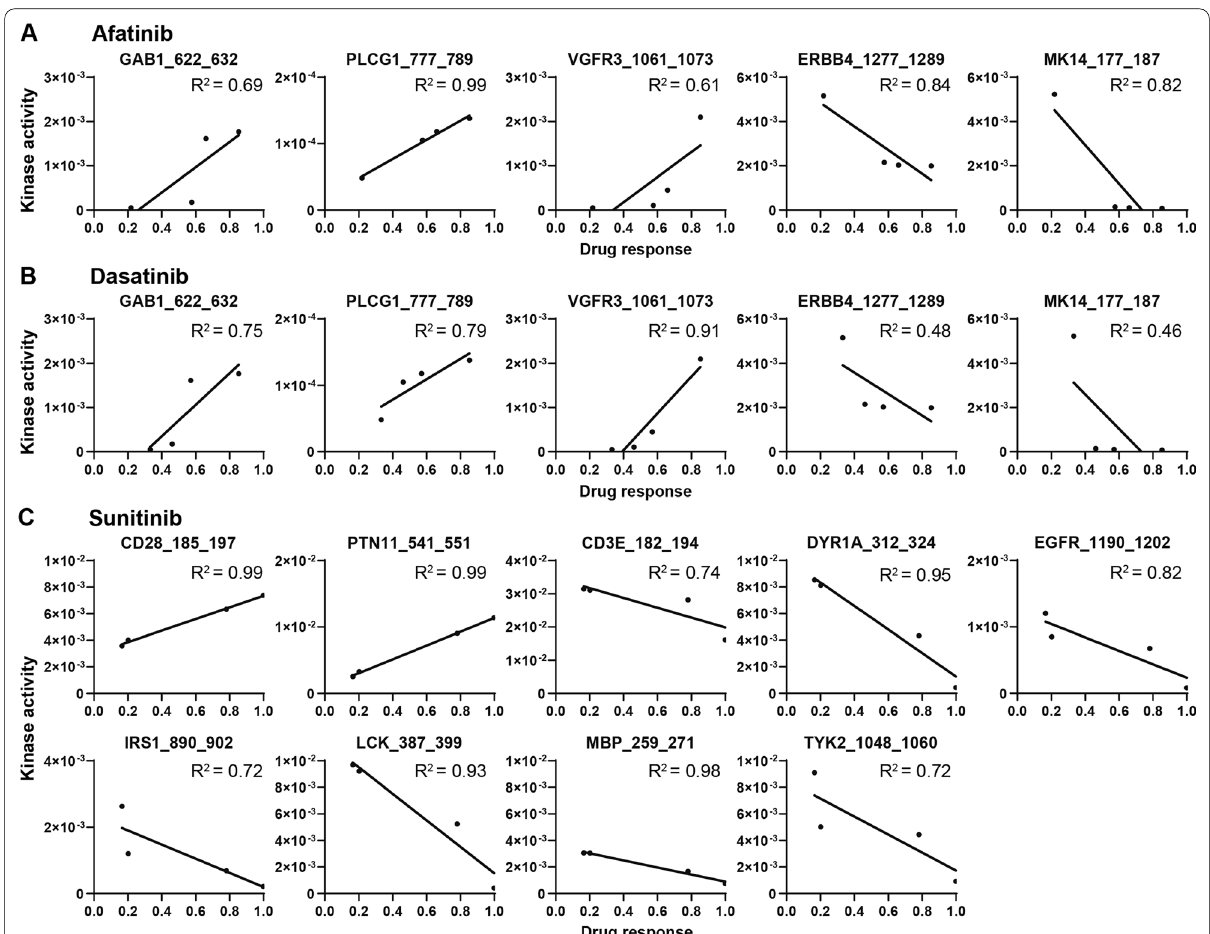
Fig. 5 Explorative correlation analysis of drug sensitivity and kinase activity. Spearman correlation analysis revealed which array peptides correlated with Afatinib ( A ), Dasatinib ( B ) and Sunitinib ( C ) treatment sensitivity. Drug response ranges from 0, indicating that organoids are unaffected by the compound, to 1, indicating there no surviving organoid cells. Significantly correlated peptides are portrayed as scatter plots with linear regression and R 2